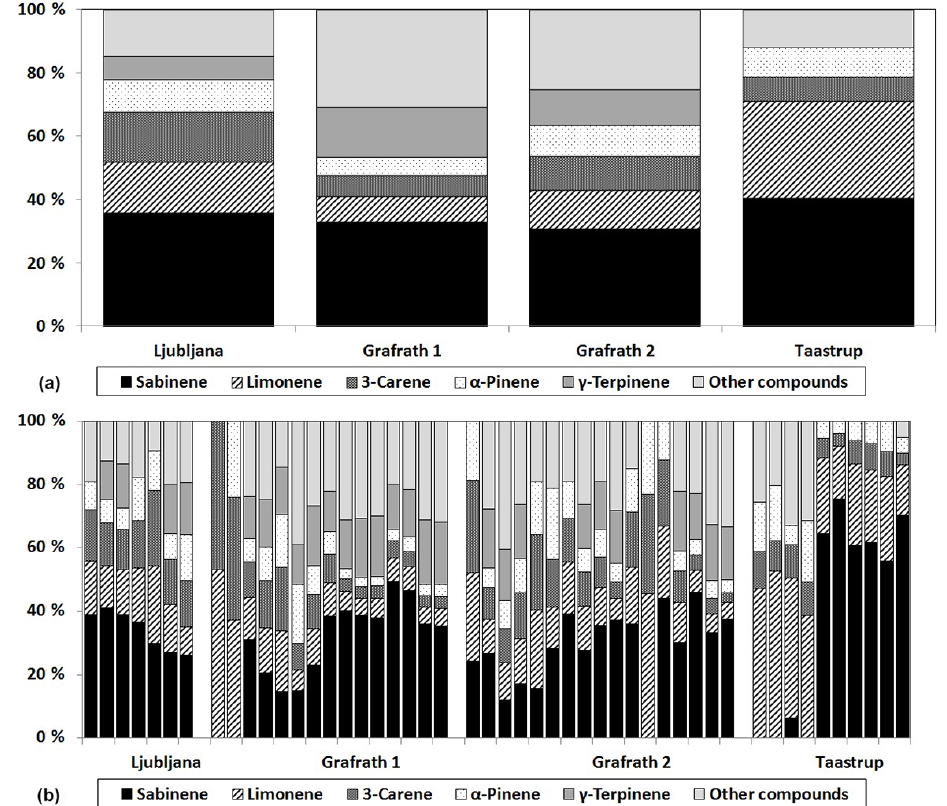
Figure 6. Relative BVOC compound contribution from European beech seen as (a) sample averages for different trees and sites and (b) for individual samples. The major emitted compounds are presented separately, whilst the remaining compounds are classified into other